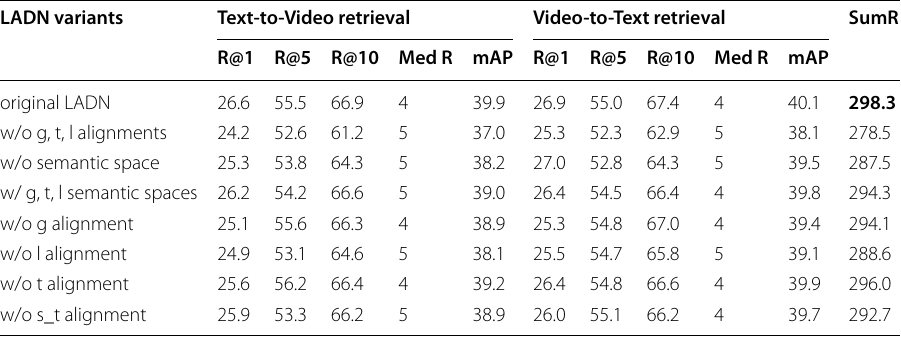
Table 5 Ablation Experiments on MSR-VTT B partition [18]. w/ and w/o mean with and without, respectively. g, t, l, s_t denote global, temporal, local, spatial–temporal, respectively LADN variants